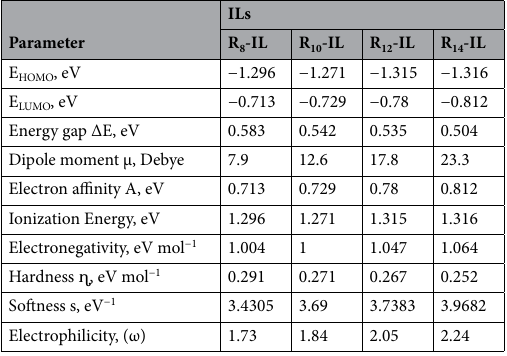
Table 6. Quantum chemical parameters of the synthesized compounds.